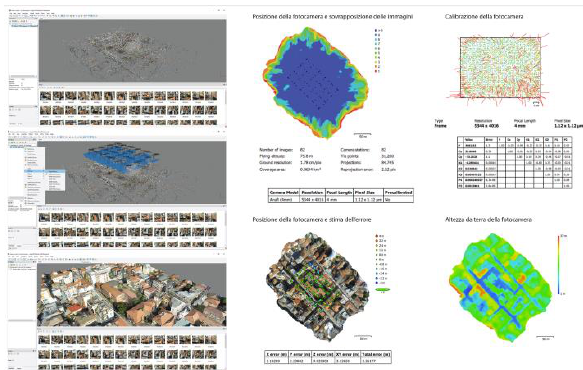
Figure 12. The measurement acquired by Earth photomodelling.